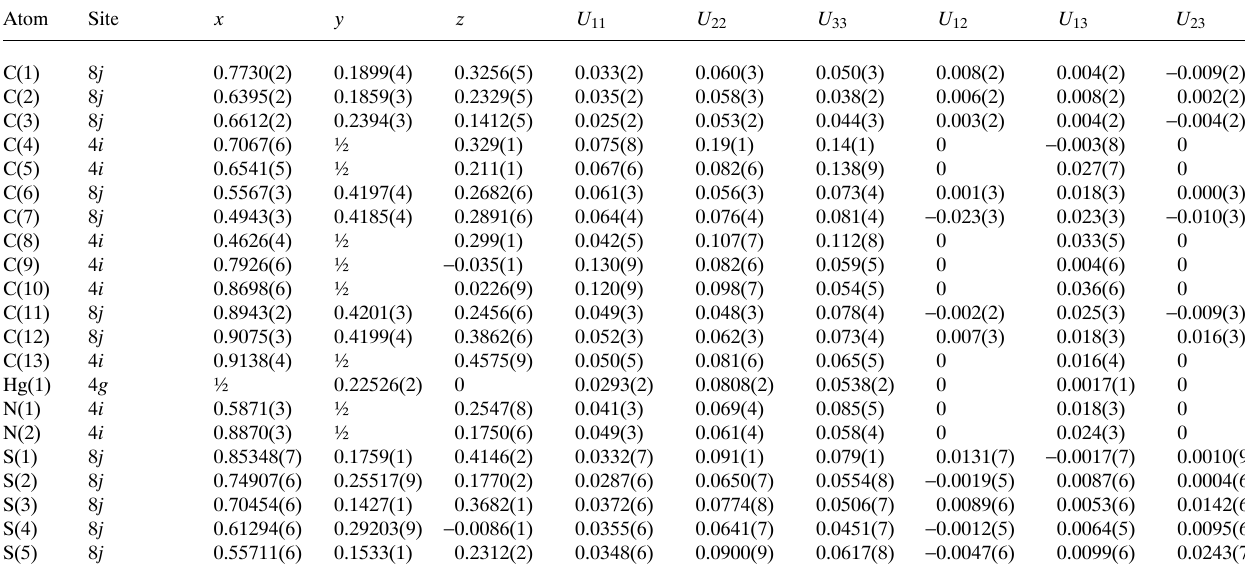
Table 3. A tomic coordin a tes a nd displ a cement p a r a meters (in Å 2 ) .